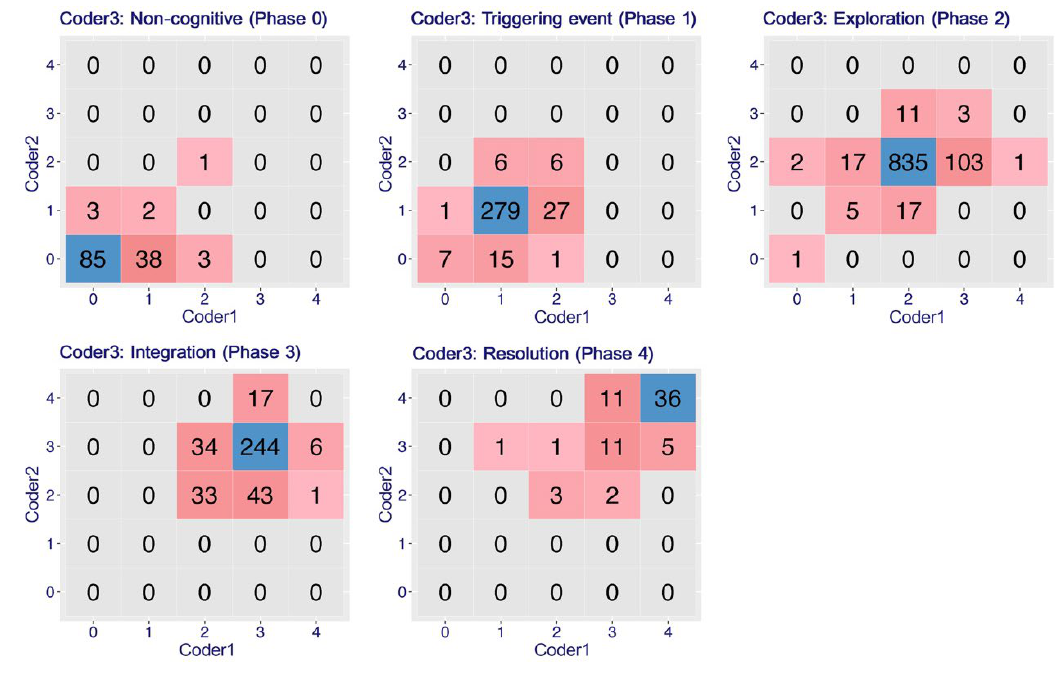
Note . Blue indicates the number of agreements among the 3 coders. Red indicates the number of disagreements. The red-colour scale is used to represent the disagreement cells. The larger the number, the darker the